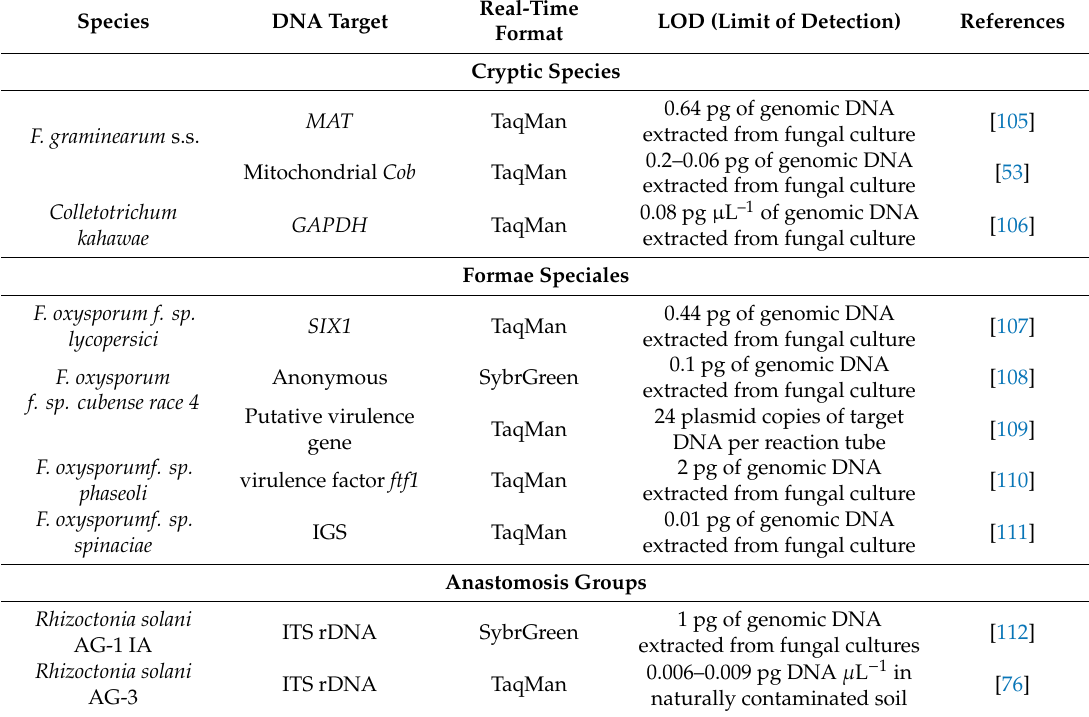
Table 2. Examples of qPCR approaches for cryptic species, formae speciales, and anastomosis groups of plant pathogenic